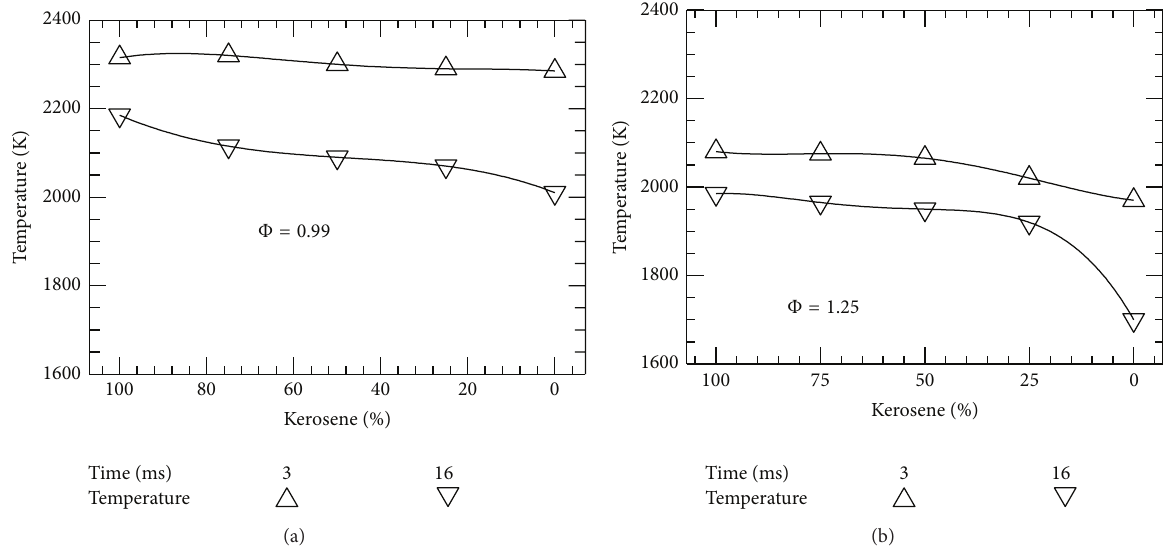
Figure 5: Effect of kerosene content on flame temperature for turbulent premixed kerosene light diesel blends-air flame for different equivalence ratios and residence time with Re = 11.08 × 10 3 and solidity ratio = 0.68.